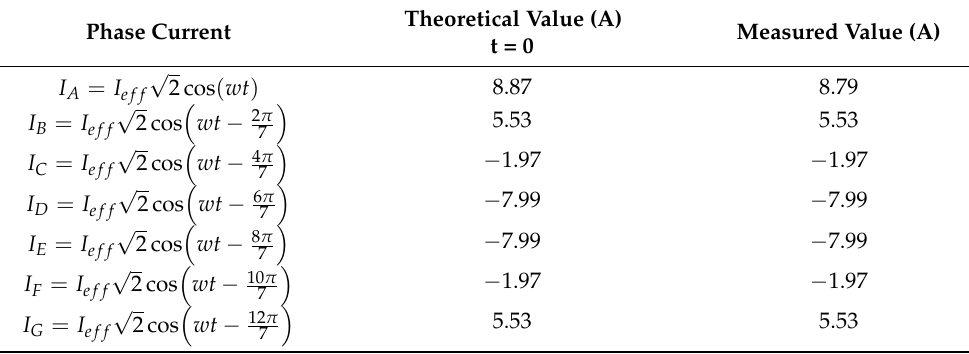
Table 8. Supplying current in each phase for the measures of the static torque.